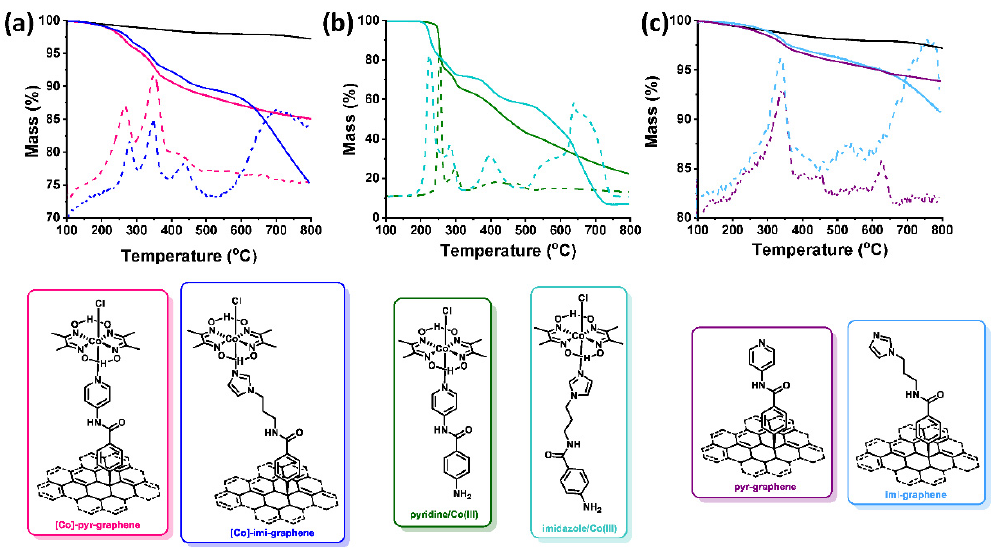
Figure 3. TGA (solid lines) and 1st weight derivative (dashed lines) of ( a ) exfoliated graphene (black), [Co]-pyr-graphene (pink) and [Co]-imi-graphene (blue), ( b ) pyridine/Co(III) (green) and imidazole/Co(III) (teal), and ( c ) exfoliated graphene (black), pyr-graphene (purple) and imi-graphene (light blue). Bottom panel: structure of functionalized materials [Co]-pyr-graphene and [Co]-imi-graphene, model compounds pyridine/Co(III) and imidazole/Co(III), and intermediate materials pyr-graphene and imi-graphene.